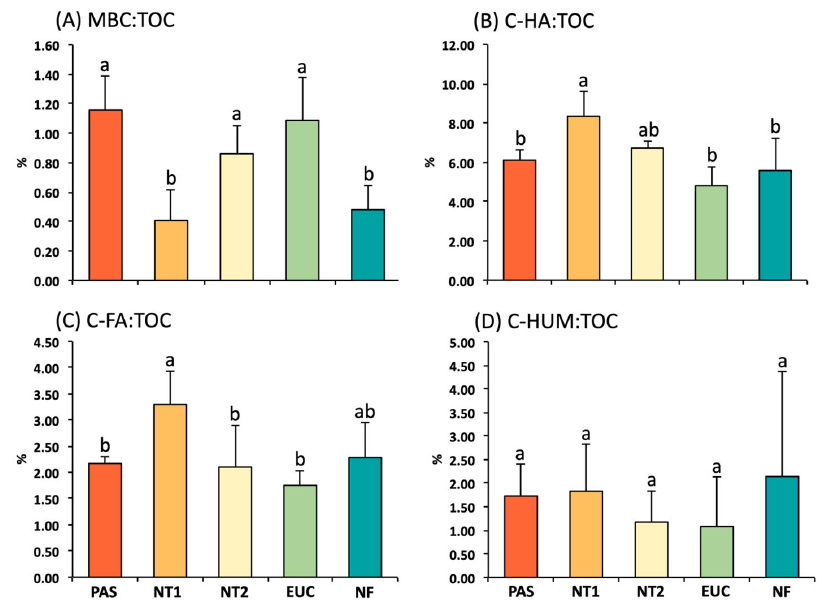
Figure 4. Microbial biomass carbon to total organic carbon (MBC:TOC) ( A ), humic acid to total organic carbon, (C-FA:TOC) ( B ), fulvic acid to total organic carbon (C-HA:TOC) ( C ), and humin to total organic carbon (C-HUM:TOC) ( D ) ratios in the 0–0.10 m depth. Vertical lines on the bars indicate standard errors of means ( n = 5). Treatments with different letters on the bars are significantly different ( p ≤ 0.05) by the Tukey test. PAS: Pasture species (Mombasa); NT1 and NT2: No-tillage system; EUC: Eucalyptus; and NF: Native Cerrado forest.